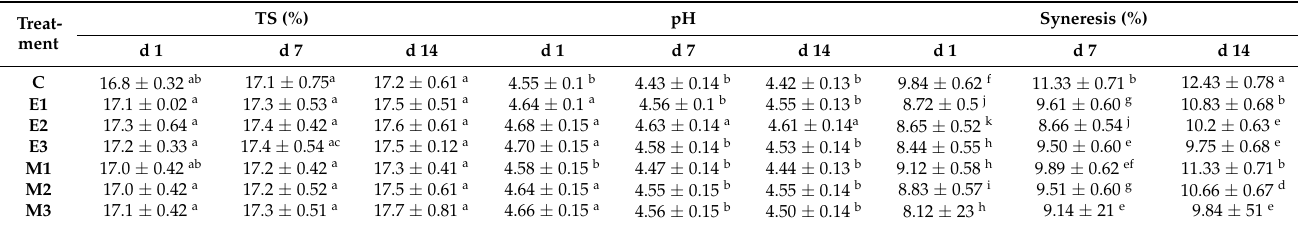
Overall Acceptability